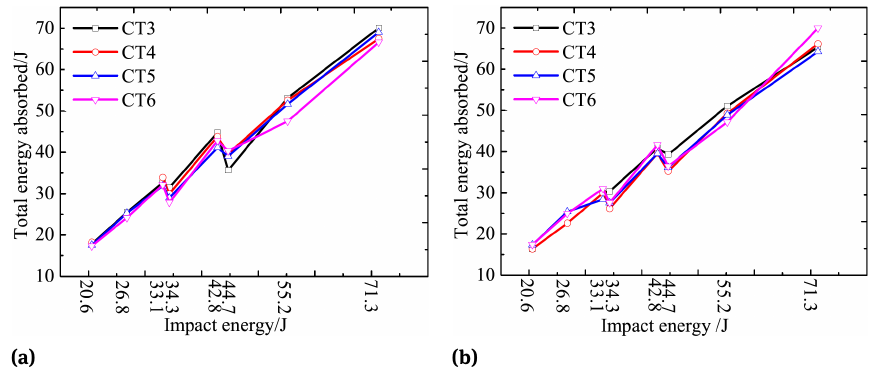
Figure 16: Influence of impact energy on total energy absorption: (a) X- and (b) Y-direction regular polygon paper corrugation tubes